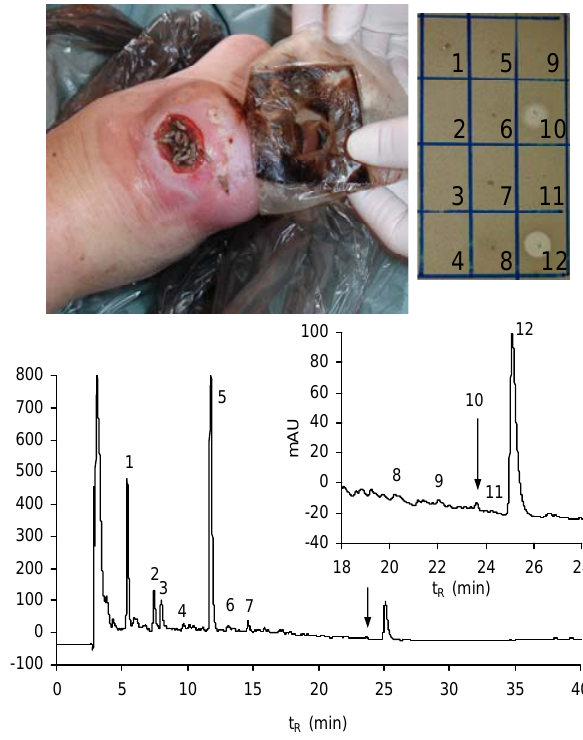
Figure 3. RP-HPLC profile (at 220 nm) of the lyophilised filtrate obtained by ultrafiltration through 10 kDa cut-off membrane of the swab extract taken from the wound (photo) immediately after removal of the larvae. An elution gradient of solvents from 5% to 70% acetonitrile/water/0.1% TFA was applied for 60 min at a flow rate 1 mL/min. Arrows indicate the anti- M. luteus active peak (10) containing lucifensin. The larger peak at t (12) represents a mixture of two human α -defensins: HNP1 and HNP2. Inset: Anti- M. luteus activity (clear zones in the drop diffusion test) of selected peaks delineated in the